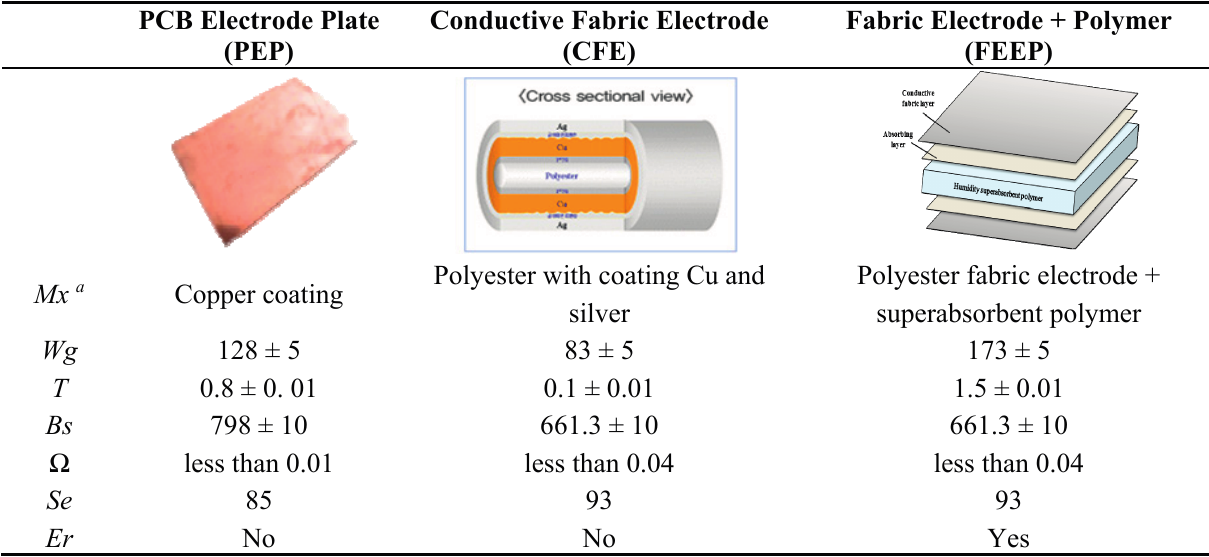
a Symbol represents the characteristics of various sensor electrodes; Mx = material, Wg = weight (g/m 2 ), T = thickness (mm); Bs = breaking strength (N), Ω = surface resistance, Se = shielding effectiveness (dB), Er = Efficiency at low